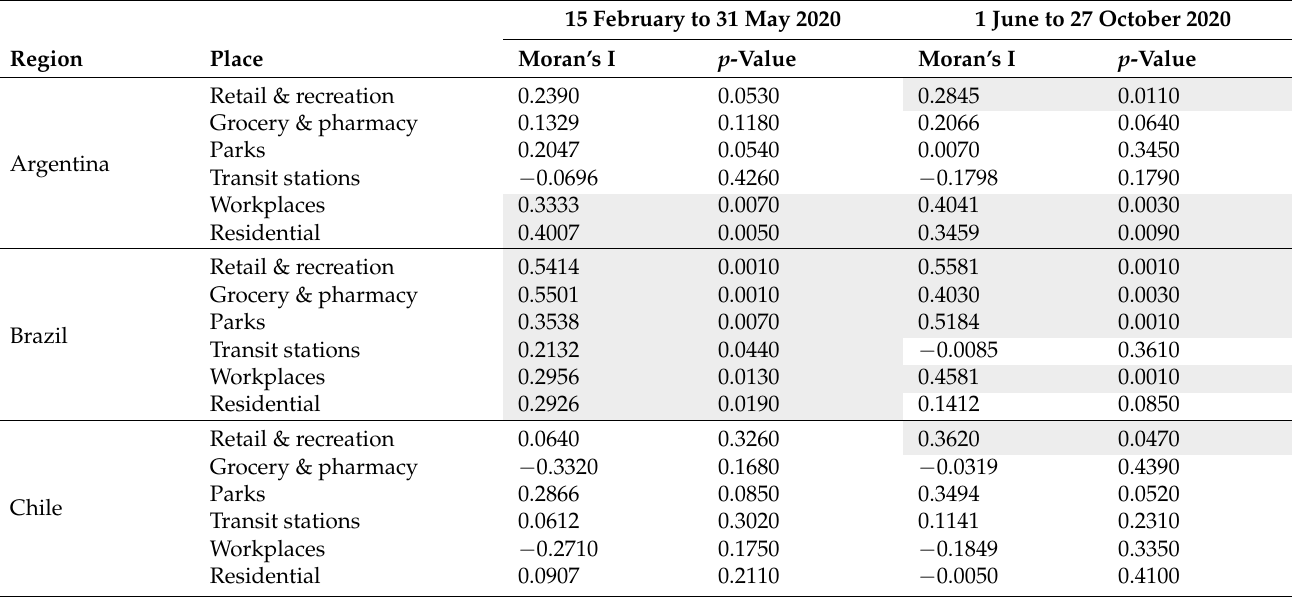
Table 2. Moran’s index I and p -value significance probability for Argentina, Brazil, and Chile considering both